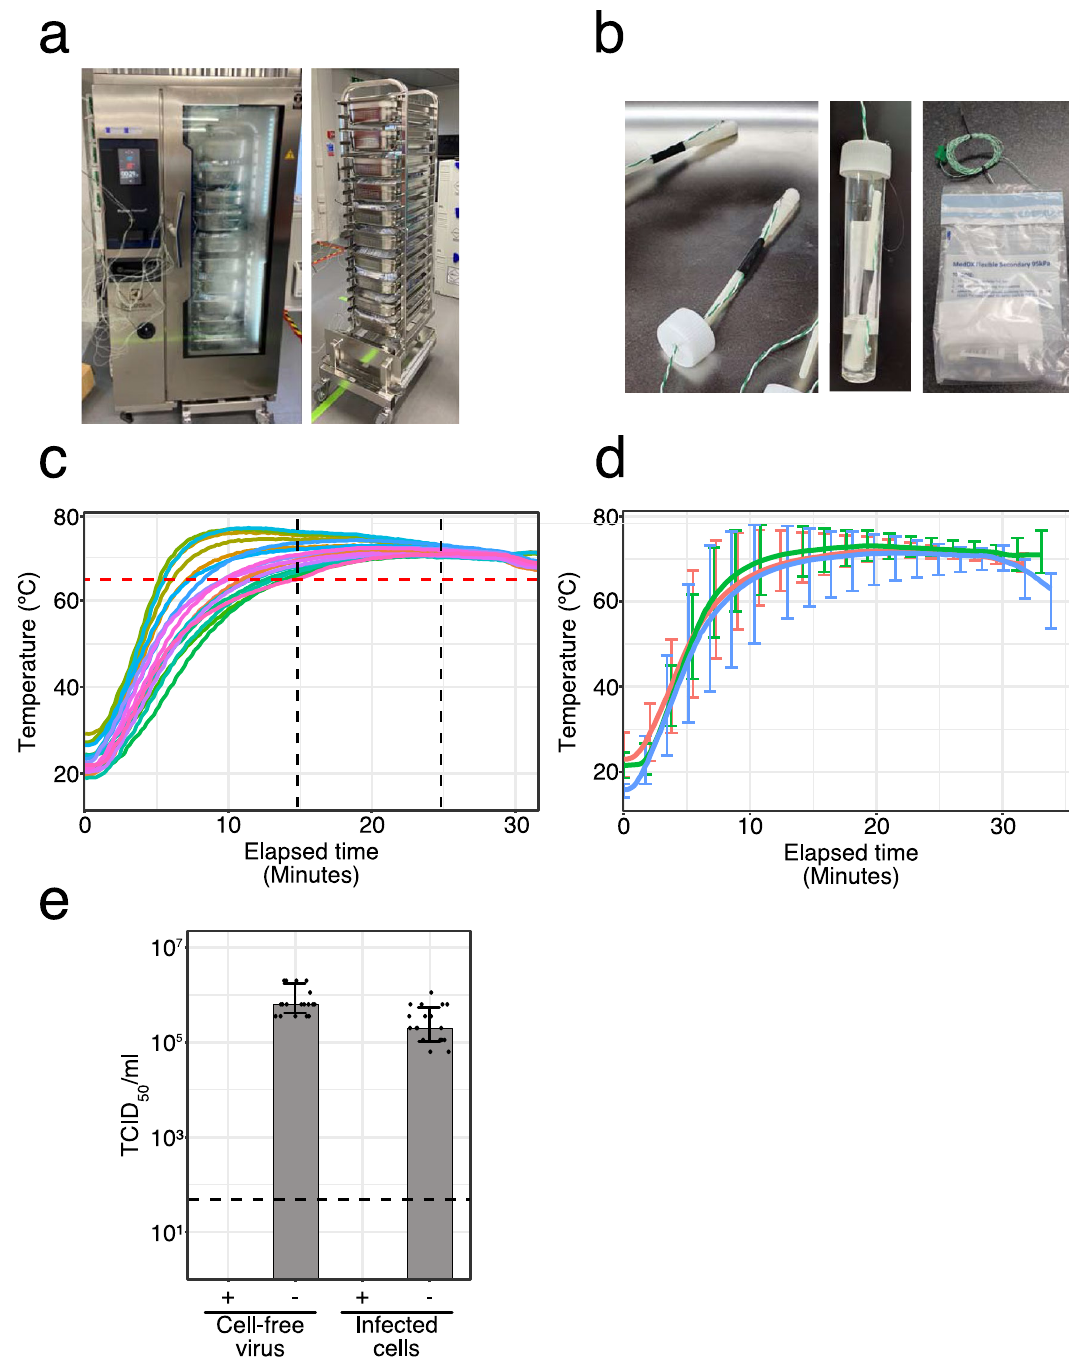
Figure 1. Validation of the industrial steam oven for bulk HI. ( a ) The Electrolux Skyline Combi Oven and the trolley loading system. The oven is shown in temperature validation mode with thermocouple wires in place. Under normal operation these are not included. ( b ) Thermocouple swab vials used for measuring temperature at the point of the swab to determine exposure of potential viable virus to heat. ( c ) An example heat mapping study showing the thermal profile of 20 thermocouple swab vials placed throughout the oven, 2 in each of 10 trays, and including 250 samples in total to mimic a full oven. Each coloured line represents an individual thermocouple swab vial ( d ) Average of three heat mapping data sets of 20 thermocouple, including that shown in ( c ). Vertical bars represent the temperature range shown for every 10th data point. ( e ) Inactivation of the SARS-CoV-2 surrogate virus MHV-A59 in the Electrolux Skyline Combi Oven using the temperature profile shown in ( c ) and ( d ), showing reduction in infectivity in human cells. Data is plotted as mean + /− standard deviation. The dashed line represents the limit of detection of the assay. Data was plotted using R (v4.1.0 “Camp Pontanezen”) with ggplot2 (v3.3.3) and the figure was assembled using Affinity Designer